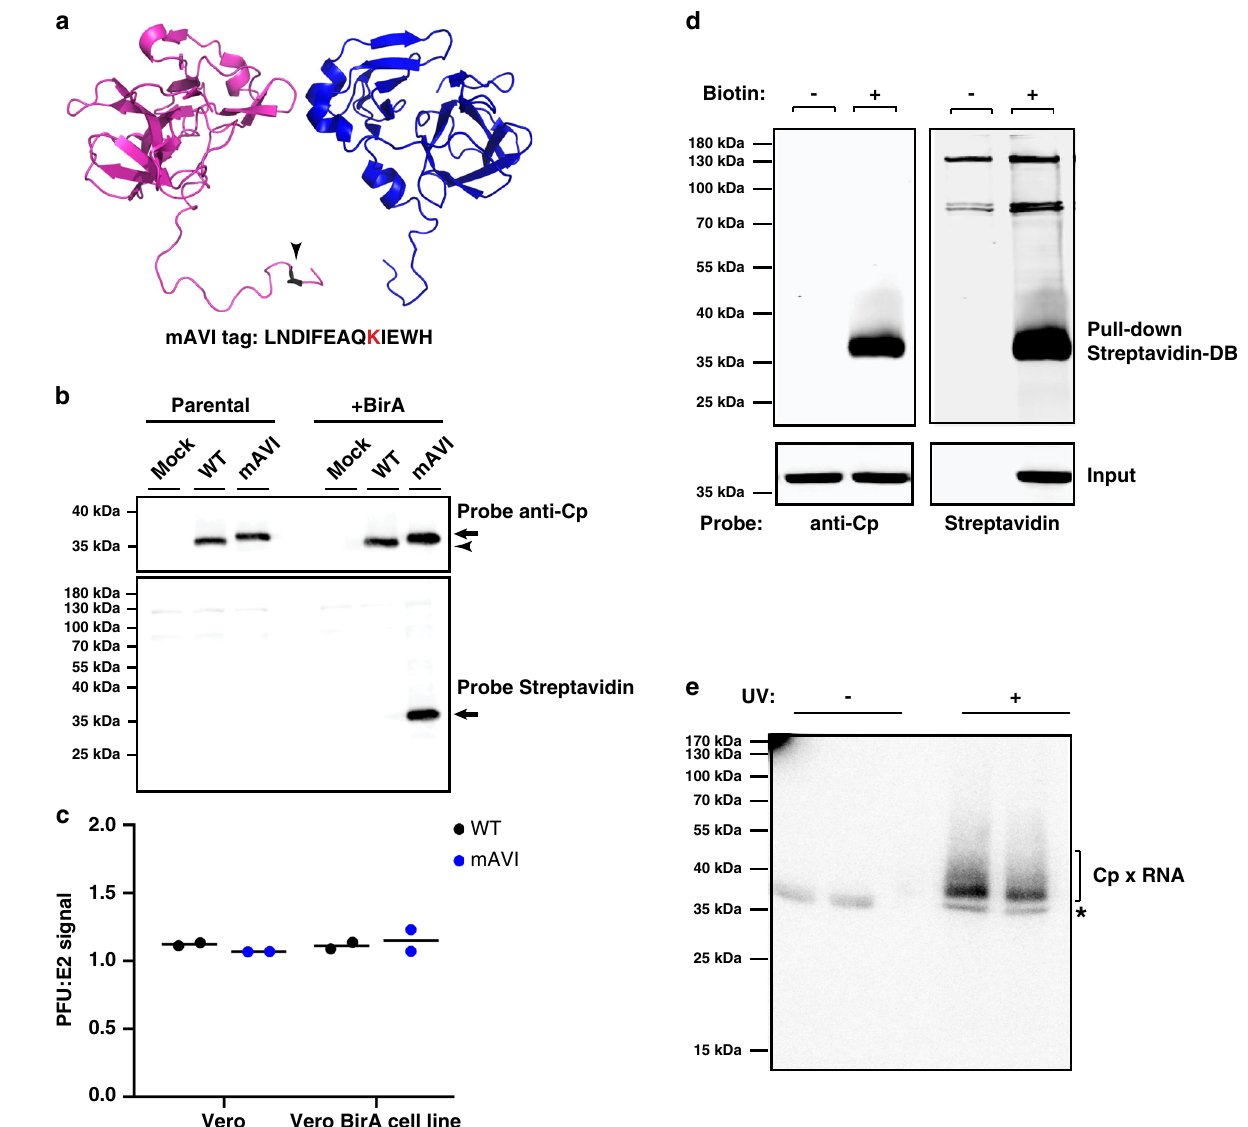
Fig. 1 Properties and retrieval of SFV Cp using mAVI tag. a Partial structure of Eastern Equine encephalitis virus Cp dimer encompassing (on the left) Cp residues 85 – 261 (PDB: 6MX7) 74 . Arrowhead indicates the homologous location where the mAVI tag was inserted in SFV Cp. The highlighted lysine residue within the mAVI tag sequence is the target for BirA biotinylation. b Vero parental or Vero BirA ( + BirA) cells were mock infected, infected with SFV WT, or infected with SFV mAVI. At 7.5 hpi, lysates were harvested, subjected to SDS-PAGE, and analyzed by western blot using a polyclonal antibody against Cp or a Streptavidin Alexa-680 probe. Arrowhead indicates Cp WT, and arrows indicate Cp-mAVI. The images are representative examples from n = 2 biological replicates. c Speci fi c infectivity was measured as the ratio of the number of infectious particles (determined by plaque assay) to the number of total particles (determined by quantitative western blot of puri fi ed virus using an E2-speci fi c antibody, see Methods section). Individual data points from two biological replicates are shown and the black line represents their mean. Units represent ratio of PFU/E2 signal. d Vero BirA cells were grown in biotin- depleted media for 3 days (-biotin) or grown in normal media ( + biotin). Cells were infected with SFV mAVI, and lysates were harvested at 7.5 hpi, retrieved with Streptavidin DynaBeads (SA-DB), and analyzed by SDS-PAGE and western blot using a monoclonal antibody against Cp or a Streptavidin Alexa-680 probe. The images are representative examples of n = 2 biological replicates. e Autoradiogram of Cp-RNA crosslinked adducts retrieved with SA-DB from Vero BirA cells infected with SFV mAVI (representative of n = 2 biological replicates). Asterisk indicates an infection- and UV-independent band (Supplementary Fig. 1e). See also Supplementary Fig.